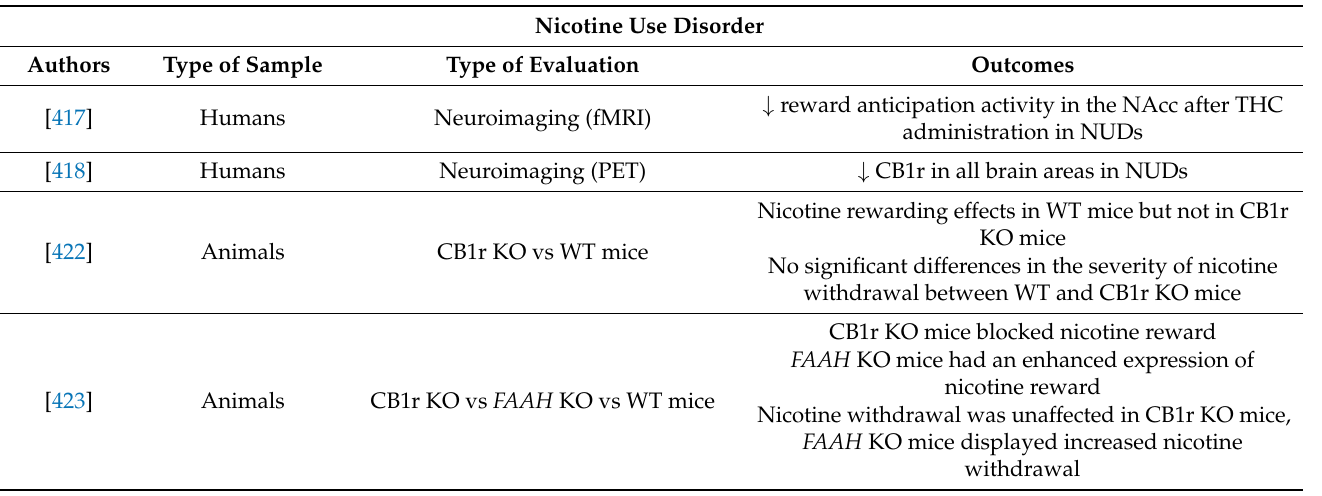
Table 1. Summary of the main findings regarding the alterations of the ECS components in animals and human studies in Nicotine Use